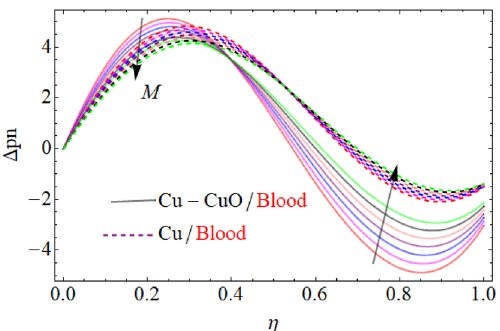
Figure 9. M influence on (cid:31) pn .